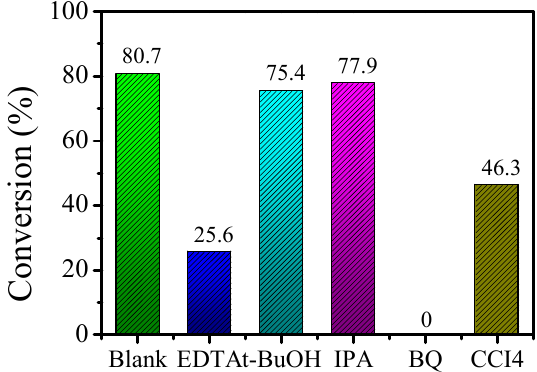
Figure 11. E ff ects of scavengers on the reaction of benzyl alcohol and